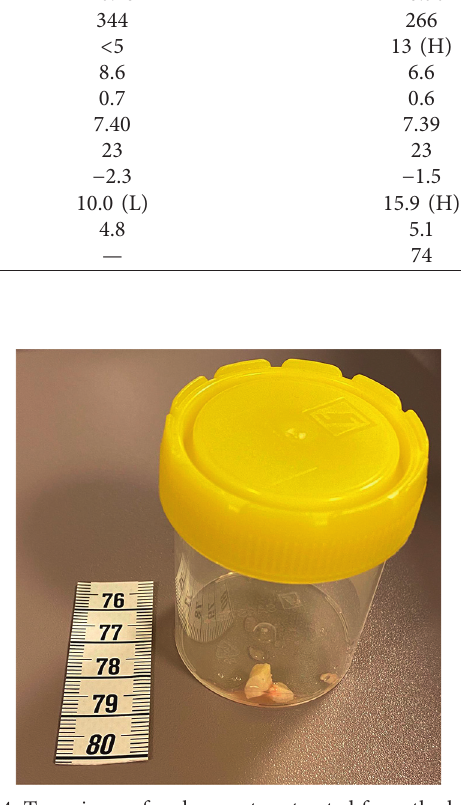
Figure 4: Two pieces of cashew nuts extracted from the left main